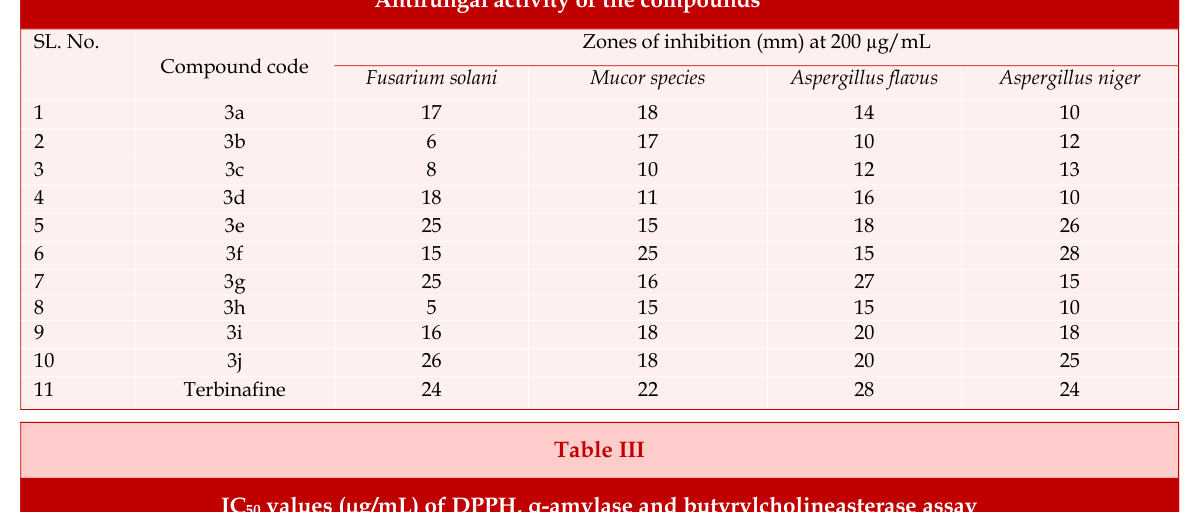
IC 50 values (µg/mL) of DPPH, α - amylase and butyrylcholineasterase assay SL.